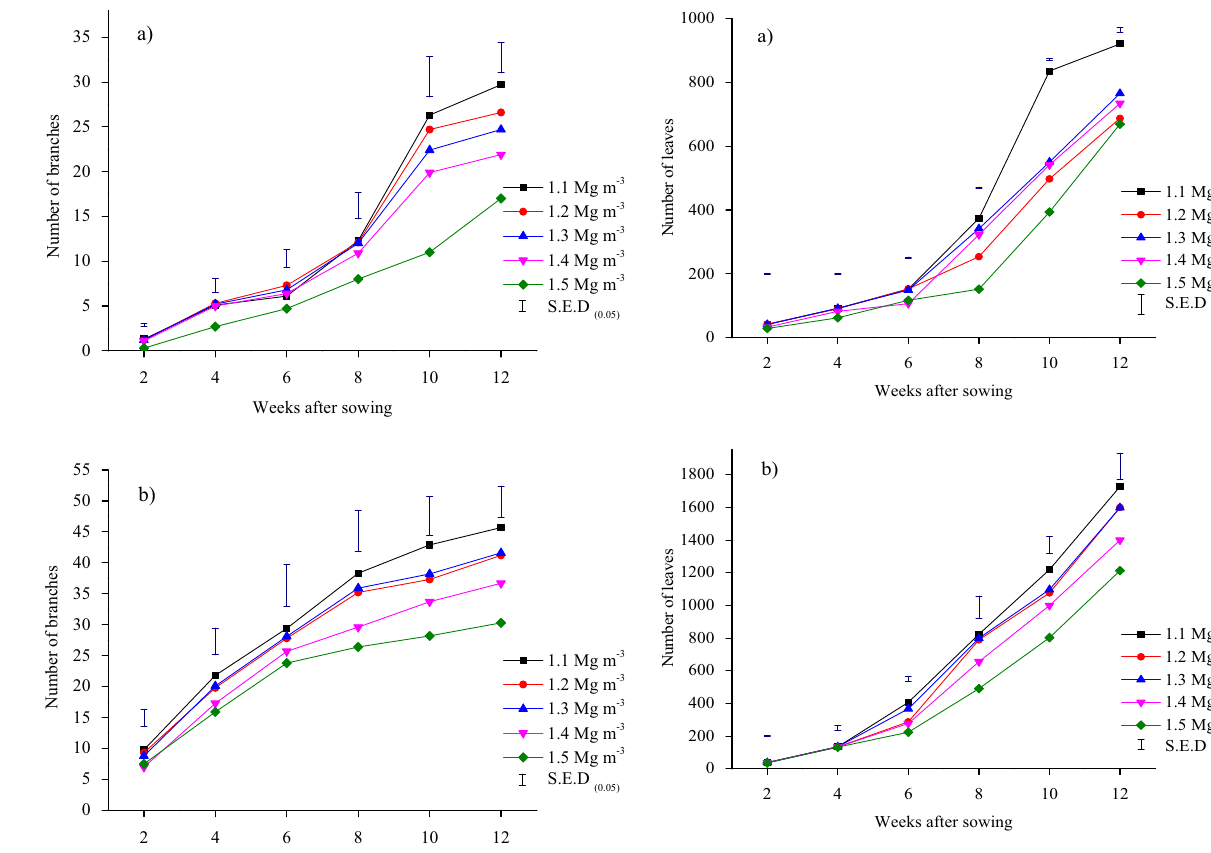
Figure 4: E ff ect of soil compaction on number of leaves of groundnut in: ( a ) year 1 and ( b ) year 2.